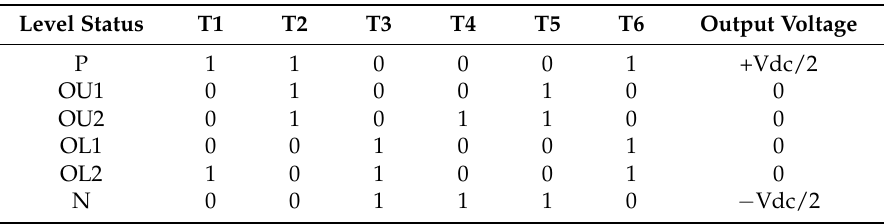
Table 2. Switching status of the ANPC three-level inverter.